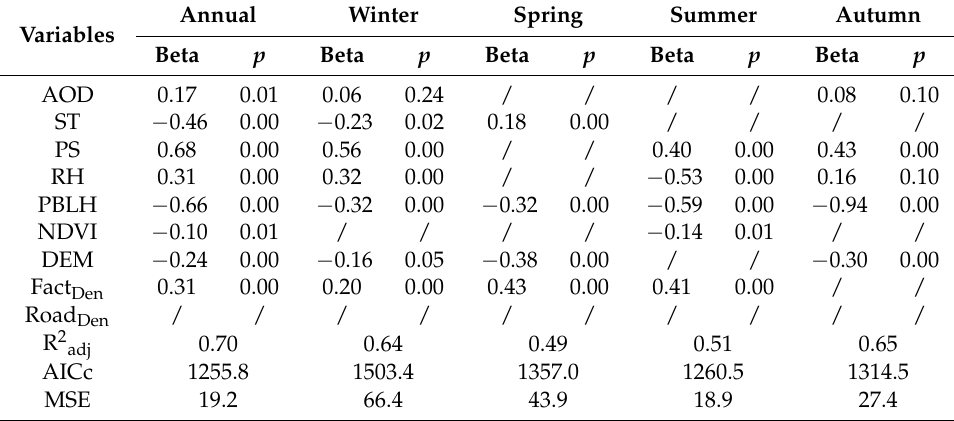
Table 5. Standardized coefficients and p -values of annual and seasonal PM 2.5 ESFR